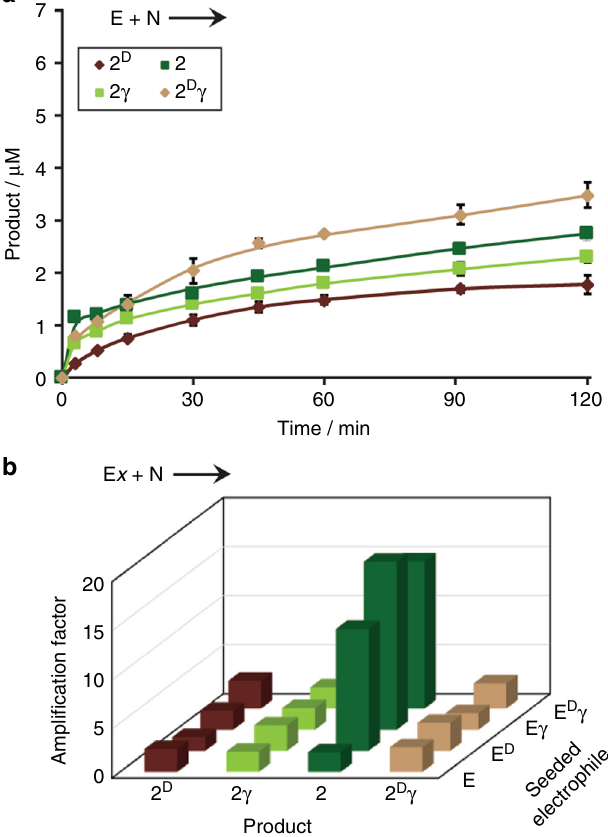
Fig. 4 Product formation in template-free reactions. a Time-dependent formation of the four isomeric products in a reaction between 200 μ M E and 300 μ M N . b Ampli fi cation factors observed in the formation of the isomeric peptides in reactions initiated with N and each of the four electrophiles, Ex , separately. The ampli fi cation factors were calculated from ratios of product formation at 120 min and 15 min for reactions initiated with the α -carboxy thioesters ( E or E D ; Supplementary Fig. 5), and the ratios at 240 and 90 min for reactions initiated with the γ -carboxy thioesters ( E γ and E D γ ; Supplementary Fig. 5). All reactions were carried out in MOPS buffer at pH 7. Product concentrations were calculated from the HPLC chromatogram by using an ABA-labeled peptide (ABA-Ala- Ala-NH 2 ) sample of known concentration as an internal